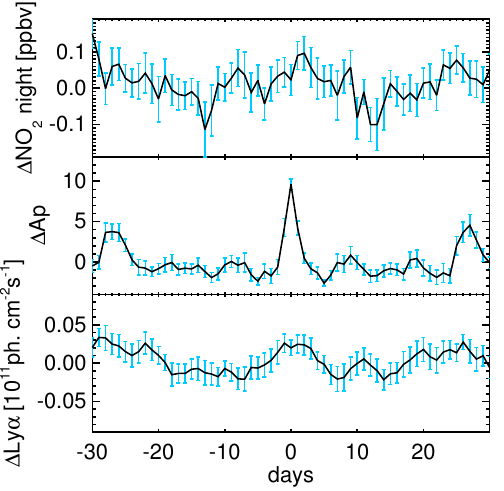
Fig. 8. SEA of 1 NO 2 at 65 ± 5 ◦ N geomagnetic latitude and differ- Fig. 8. SEA of ∆NO 2 at 65 ± 5 ◦ N geomagnetic latitude and dif- ent altitudes (black). In red the corresponding fits. ferent altitudes (black). In red the corresponding fits.